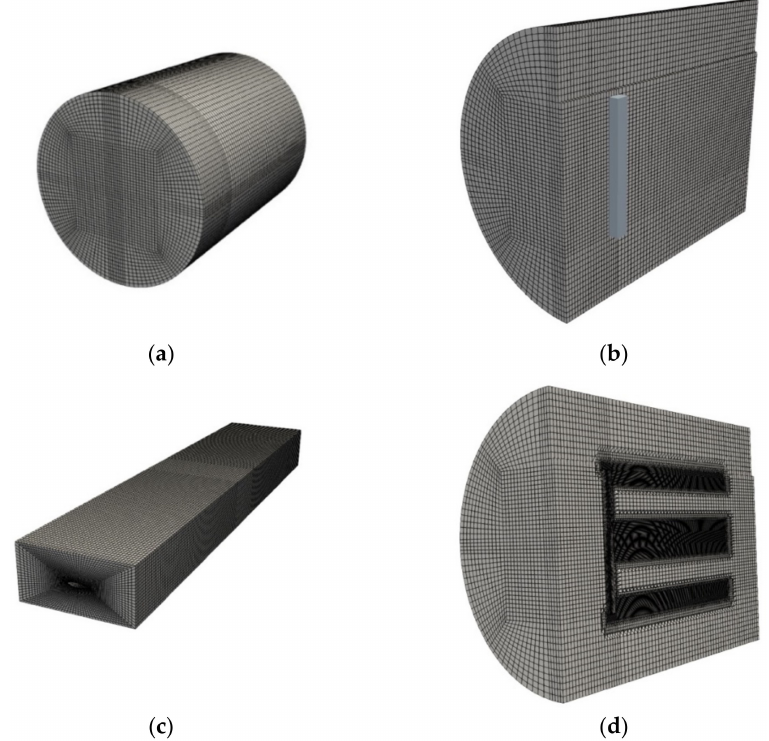
Figure 2. The general structure of the fluid domain mesh with the 721,090 structural mesh cells in number: ( a ) Fluid domain mesh ( b ) Initial fluid domain mesh; ( c ) Fluid domain inner mesh; ( d ) Fluid domain refined mesh: cross-section view.